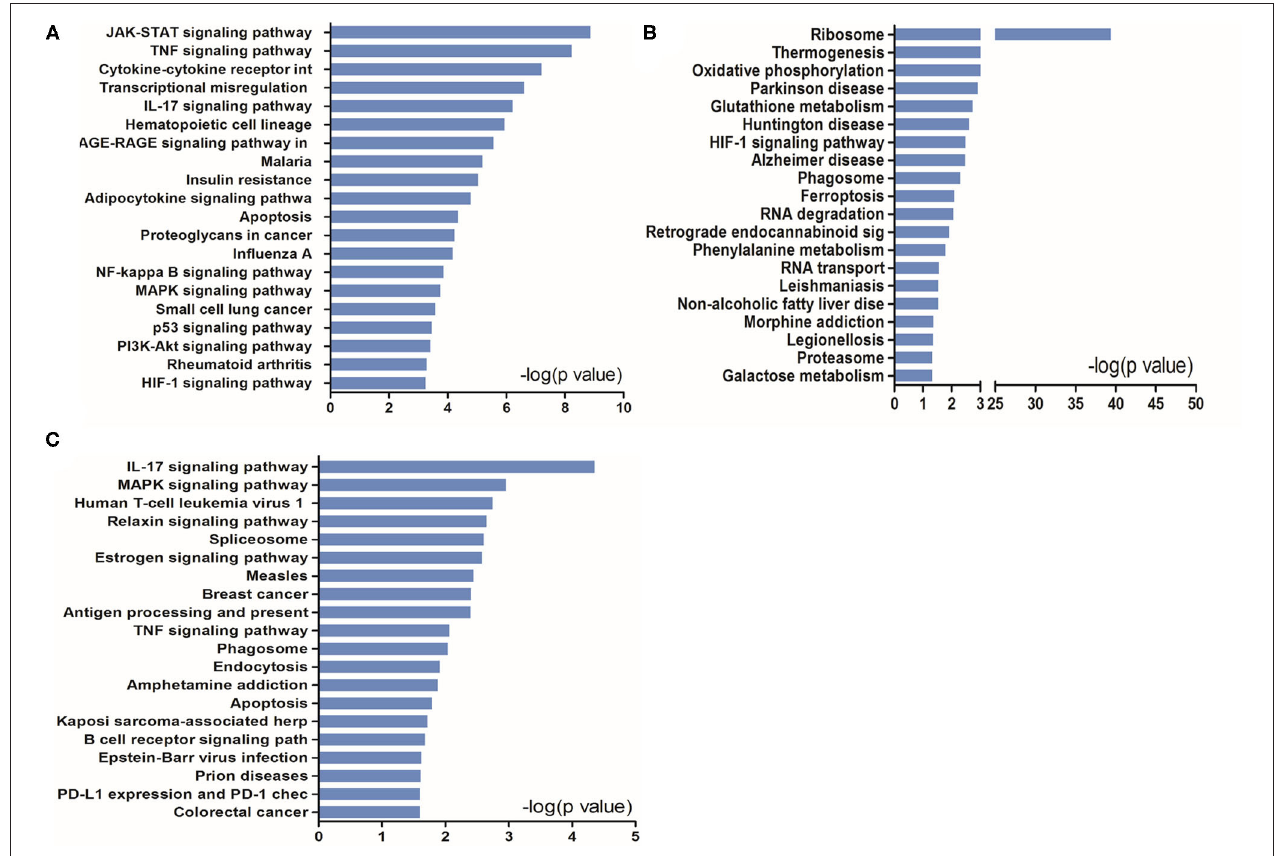
FIGURE 6 | KEGG pathway analysis of up- and downregulated genes in the heart tissues in the presence or absence of Stat5 . (A) The top 20 KEGG pathways were drawn from the 919 differentially expressed genes (DEGs) between the Stat5 fl / fl + I/R group and the Stat5 fl / fl + EA + I/R group shown in Figure 5 . (B) The top 20 KEGG pathways were drawn from the 906 DEGs between the Stat5- cKO + I/R group and the Stat5- cKO + EA + I/R group shown in Figure 5 . (C) The top 20 KEGG pathways were drawn from the 133 co-regulated genes shown in Figure 5 .